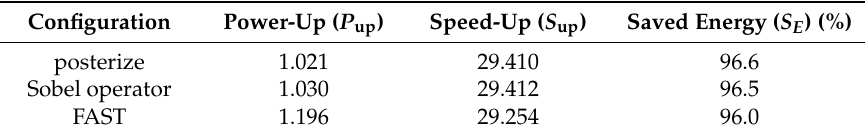
Table 2. The average energy efficiency of the proposed